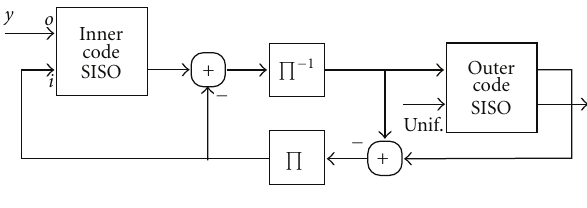
Figure 8: Structure of the